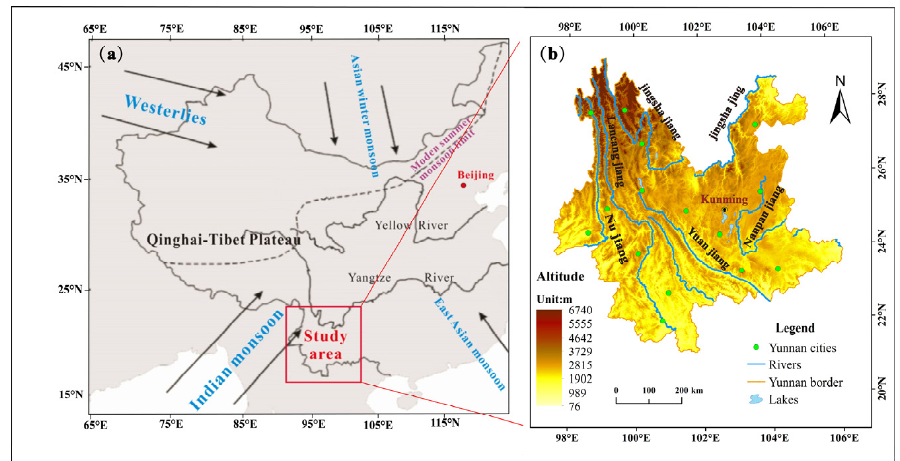
Figure 1. ( a ) Location of the study area. ( b ) Distribution of meteorological sites in Yunnan.